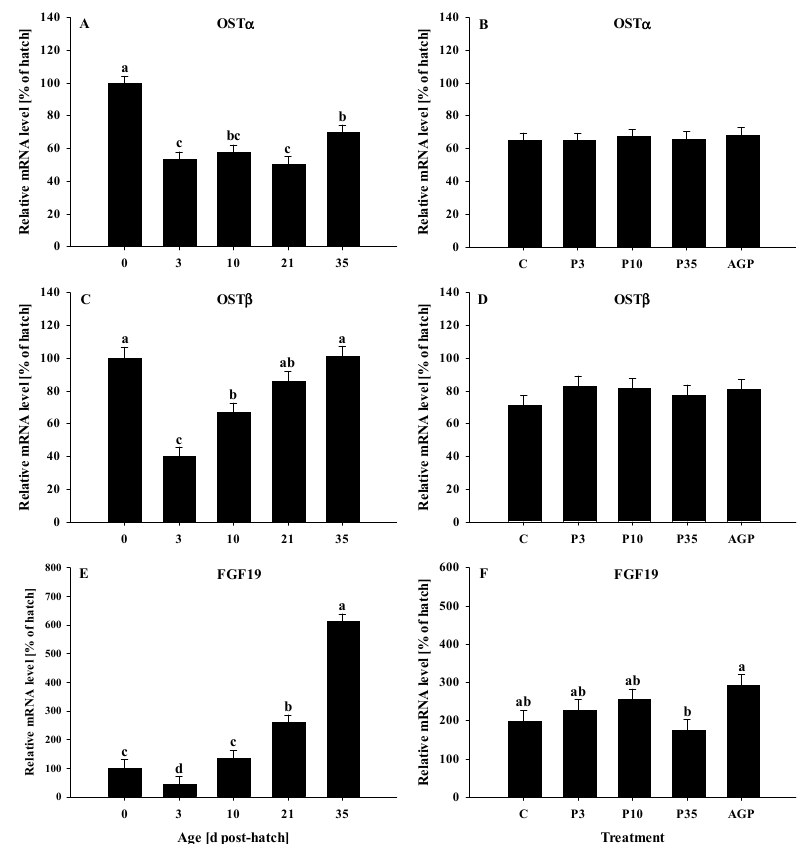
Figure 2. Age and treatment effects on mRNA levels of genes associated with bile acid metabolism in the ileum. Age effects on ( A ) organic solute transporter alpha (OST α ), ( C ) organic solute transporter beta (OST β ), and ( E ) fibroblast growth factor 19 (FGF19). Treatment effects on ( B ) OST α , ( D ) OST β , and ( F ) FGF19. The expression level of hatch (day 0) was set to 100%, and other values were calculated as a % of the hatch data. Each value represents mean ±SE. Treatments are C, normal water (without supplements) from days 0 to 35 post-hatch; P3, FM in water for first 3 days post-hatch, followed by normal water until day 35; P10, FM in water for first 10 days post-hatch, followed by normal water until day 35; P35, FM in water from hatch to day 35; and AGP, AGP in water from hatch to day 35. a,b,c,d Letters indicate significance ( p < 0.05) between days post-hatch or treatments.